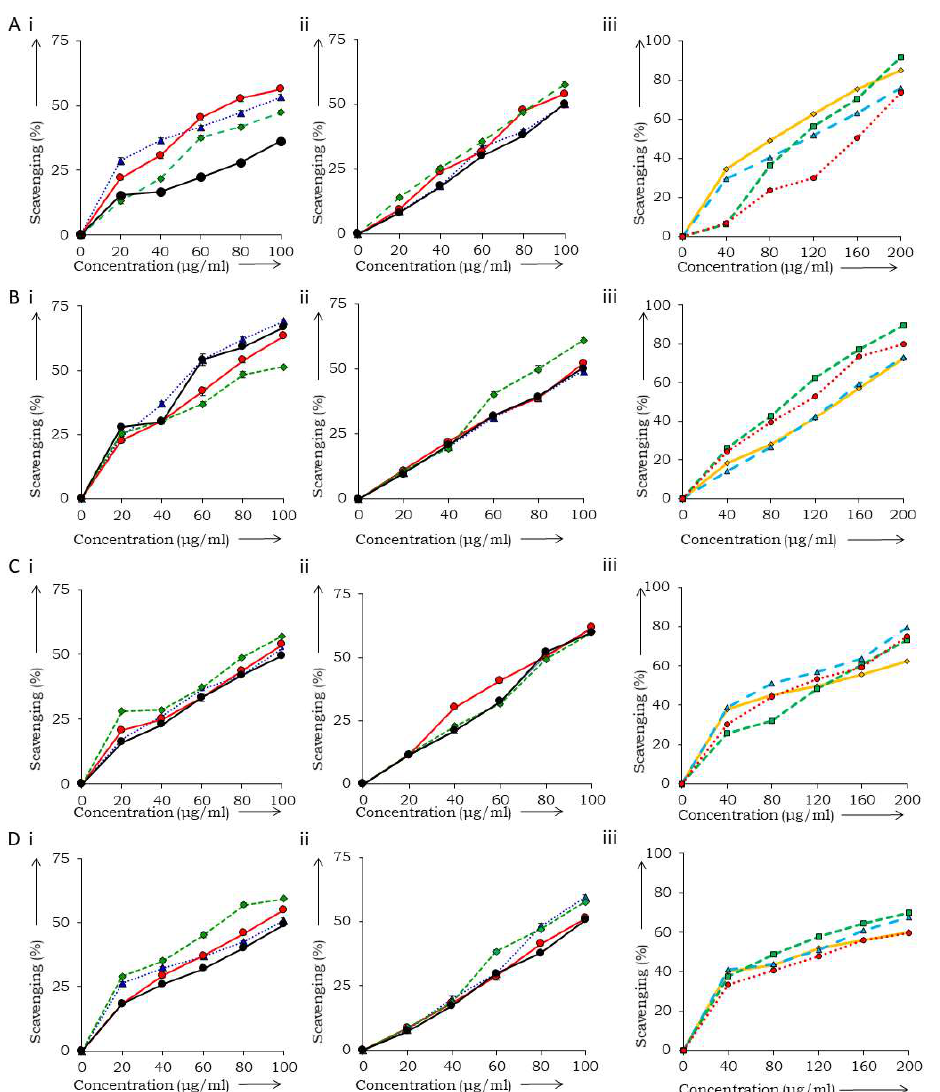
Figure 1. In vitro antioxidant assays ( A ) DPPH assay, ( B ) hydrogen peroxide scavenging assay, ( C ) nitric oxide scavenging assay, ( D ) total antioxidant assay of R. cordifolia root without (i) and with (ii) polyvinylpolypyrrolidone (PVPP), where: blue—ethanol extract, red—methanol extract, dark green—aqueous extract, black—ascorbic acid and (iii) leaf and stem, where: green—leaf-methanol extract (−PVPP), orange—methanol extract (+PVPP), red—stem-methanol extract (−PVPP), blue— stem-methanol extract (+PVPP). Table 4. IC 50 values of DPPH, hydrogen peroxide, nitric oxide and total antioxidant assay of R . cor- difolia . Results were expressed as the mean ± SD of three independent experiments. Significant dif- ference between without PVPP and with PVPP representing p < 0.001, p < 0.01, p < 0.05 is by ***, ** and *, respectively. R. cordifolia extracts were tested at concentrations of 20, 40, 60, 80, 100 µg/mL.